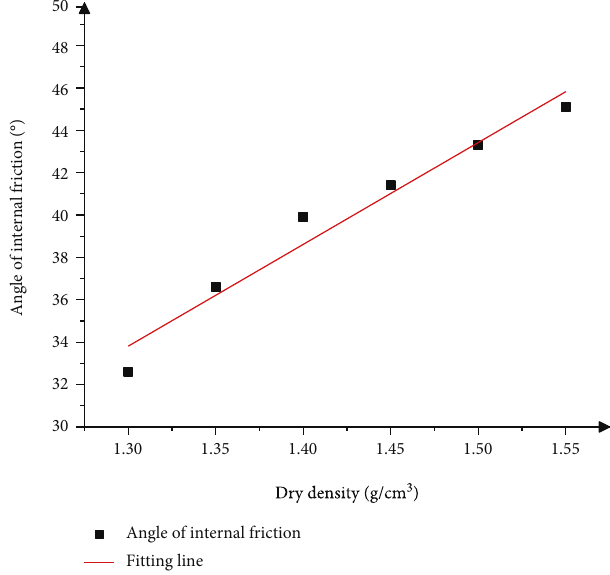
Figure 4: Curve of relationship between internal friction angle and dry density. Table 3: Breakage values of particles in the direct shear test.